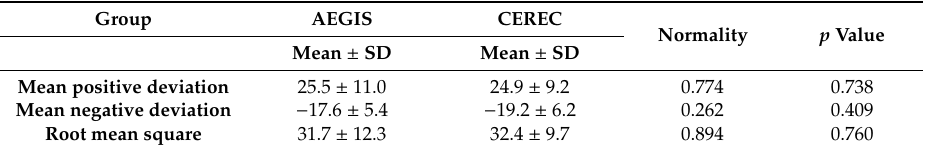
Table 4. Results (in micrometers) obtained by superimposition of the CI dataset with datasets obtained using the AEGIS and CEREC scans.